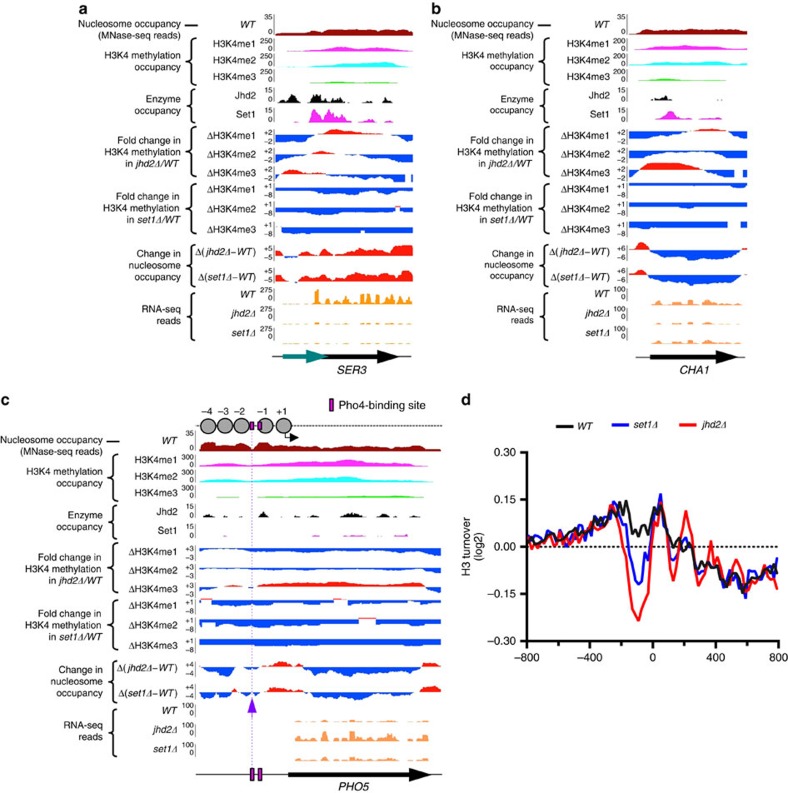
Co-regulation of nucleosomal occupancy and transcription by Set1 and Jhd2 at candidate target genes.(a–c) Changes to H3K4 methylation levels, nucleosomal occupancy and transcripts at SER3, CHA1 and PHO5 genes in jhd2Δ or set1Δ are shown. The normal nucleosomal, H3K4 methylation, Jhd2 and Set1 occupancies at target genes are also shown: reads for mononucleosomal DNA in WT shows native chromatin organization (brown). Reads for H3K4 monomethyl (me1, magenta), H3K4 dimethyl (me2, cyan) and H3K4 trimethyl (me3, green) marks in WT shows their distribution over candidate target genes. Enrichment values (qpois) for Jhd2 (black) and Set1 (pink) in WT show their occupancy at the indicated genes. Fold-change in the levels of H3K4me1, H3K4me2 and H3K4me3 marks in jhd2Δ or set1Δ relative to that in WT are shown. Fold-change in H3K4 methylation in set1Δ relative to WT was calculated using published datasets42. Increase or decrease in a given H3K4 methyl mark in the mutant is shown in red or blue, respectively. Mononucleosomal DNA from WT were subtracted from those obtained from jhd2Δ or set1Δ and visualized using a genome browser. Gain or loss in nucleosome occupancy in the mutant is represented in red or blue, respectively. RNA-seq reads showing transcript levels for the three target genes in WT, jhd2Δ or set1Δ strains are shown (orange). Teal arrow indicates SRG1, a gene coding for regulatory non-coding RNA involved in SER3 regulation34. In c, schematic diagram at top shows the nucleosome organization at PHO5. Circles, well-positioned promoter nucleosomes; black arrow, TSS; and pink box, the Pho4 binding site, determined using published datasets6970. Grape coloured arrow and dotted line indicate decrease in nucleosomal occupancy at the Pho4 binding site. (d) The average mean profile for histone H3 turnover across 800 bp region upstream (−) or downstream (+) of the TSSs (0) at all 236 yeast ribosome biogenesis or Ribi genes in WT, set1Δ and jhd2Δ are shown.